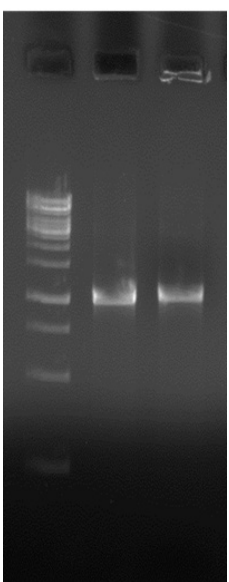
Fig. 4. Agarose gel electrophoresis. M- 100bp DNA Ladder , L1 and L2 –